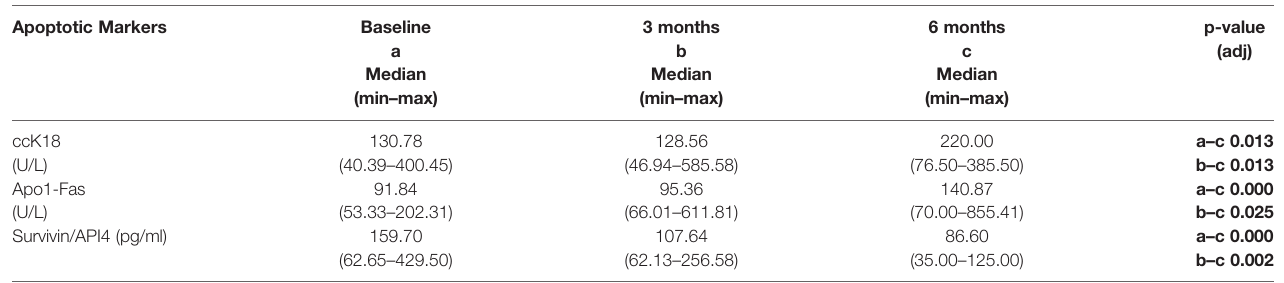
TABLE 4 | Differences in apoptosis markers of patients with CLL (N = 22) during the DI2 with High OC/OL - EVOO.